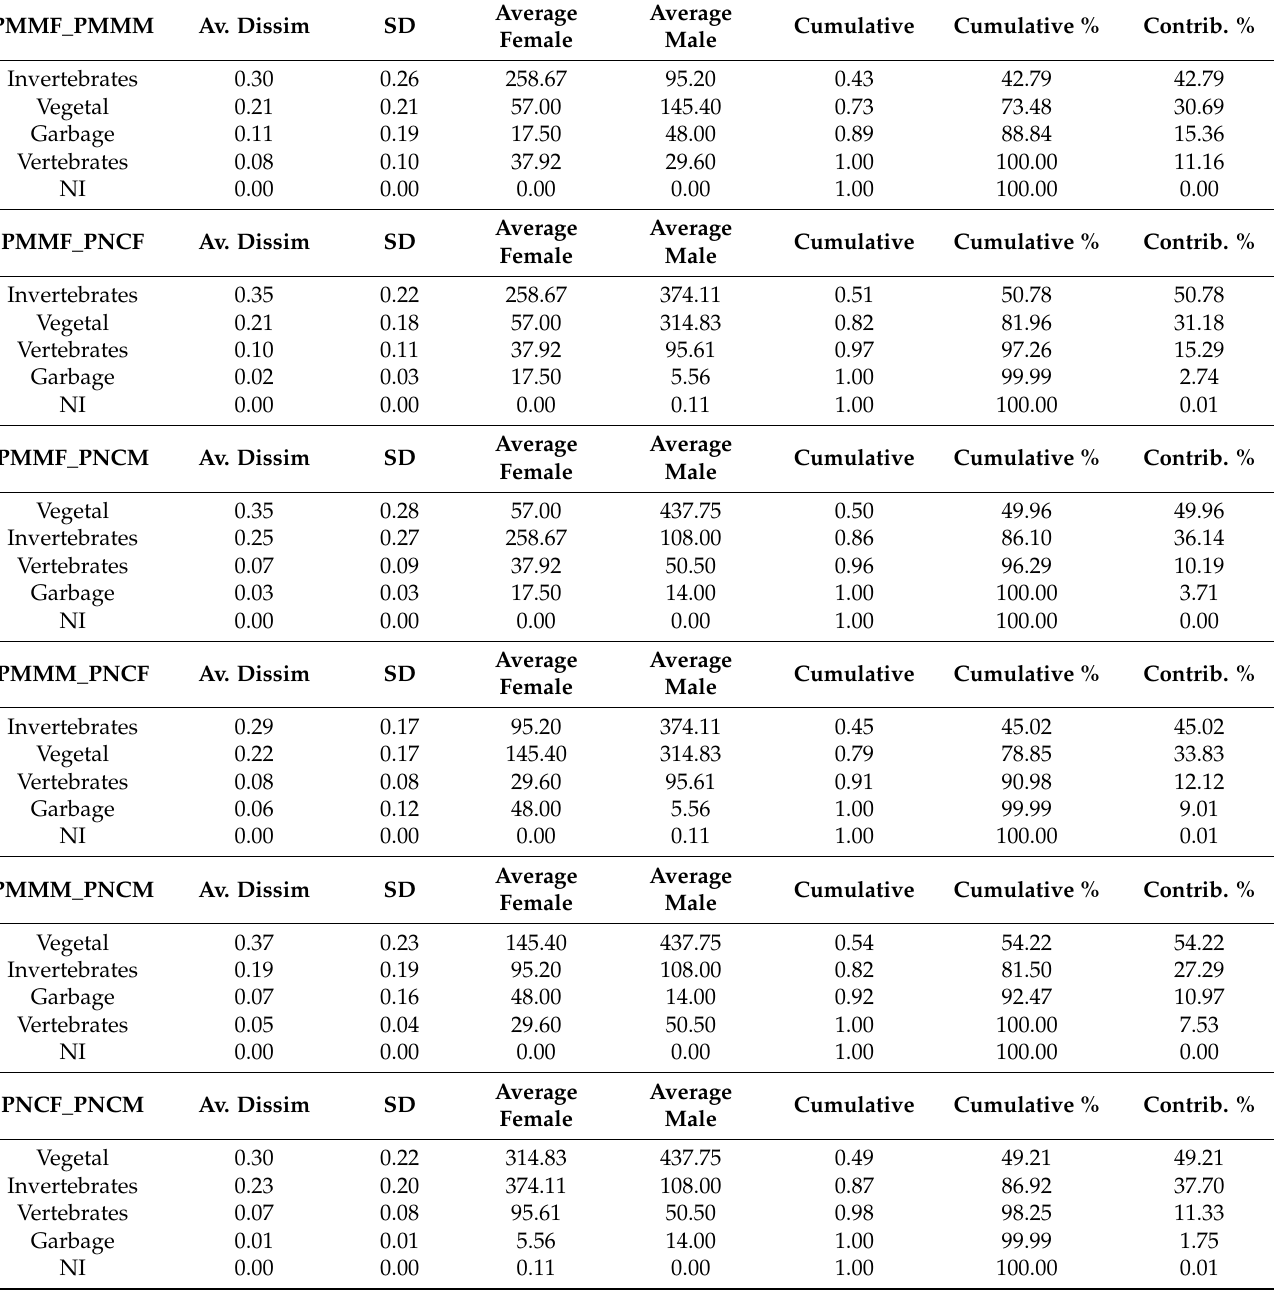
Table 2. Contrast tables of the contribution of individual food categories (garbage, vertebrates, invertebrates, vegetal, and unidentified) to the overall Bray–Curtis dissimilarity of the composition of food ingested by females and males of coatis ( Nasua nasua ) in two different parks (PMM and PNC). PMMF—PMM and female coati, PMMM—PMM and